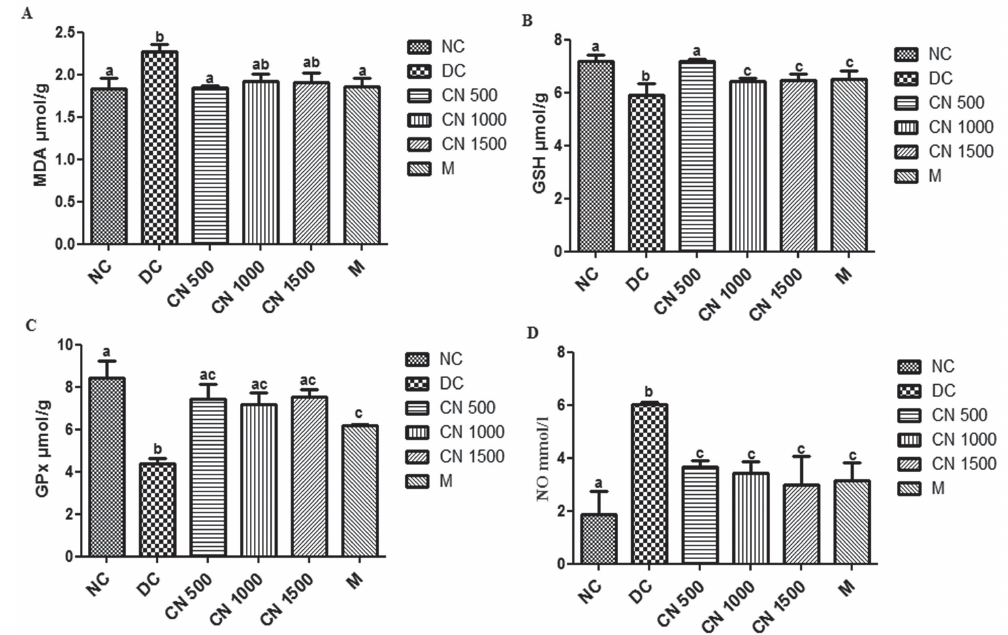
FIGURE 4 - The aorta MDA (A), GSH (B), GPx (C) levels and NO (D) activitiy in experimental groups (a-b-c=p<0.05 (A), a-b=p<0.01, a-c=p<0.05, b-c= p<0.05 (B and C), a-b=p<0.001, b-c=p<0.01, a-c= p<0.05 (D) n= 10 there is no statistical difference among the groups expressed the with same